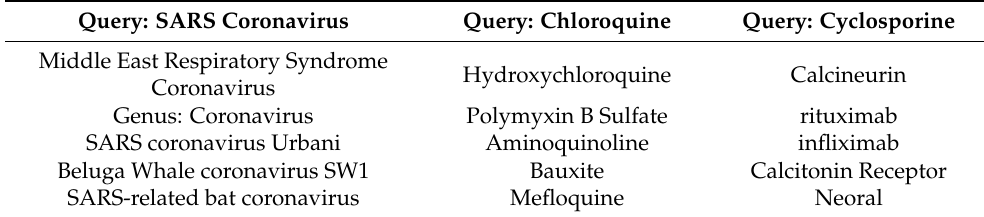
Table 2. Example results from the Embedding API with different input queries. Input Parameters are (entity: as shown in table, size: 5 and method: